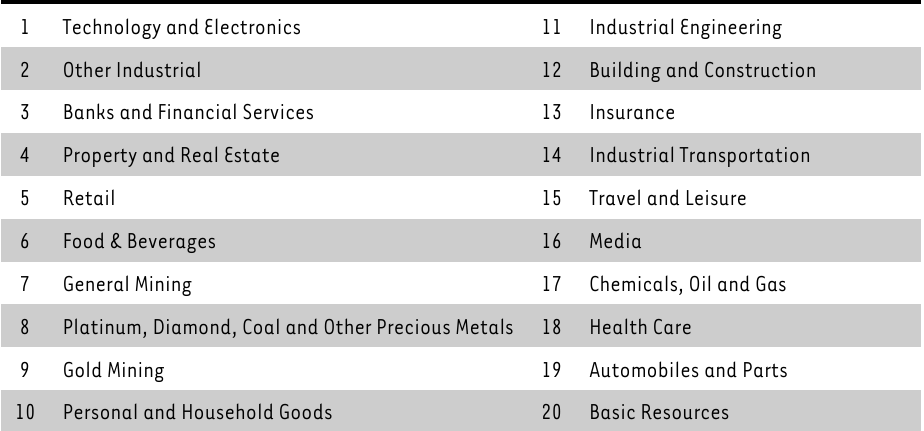
TABLE 1: Industry